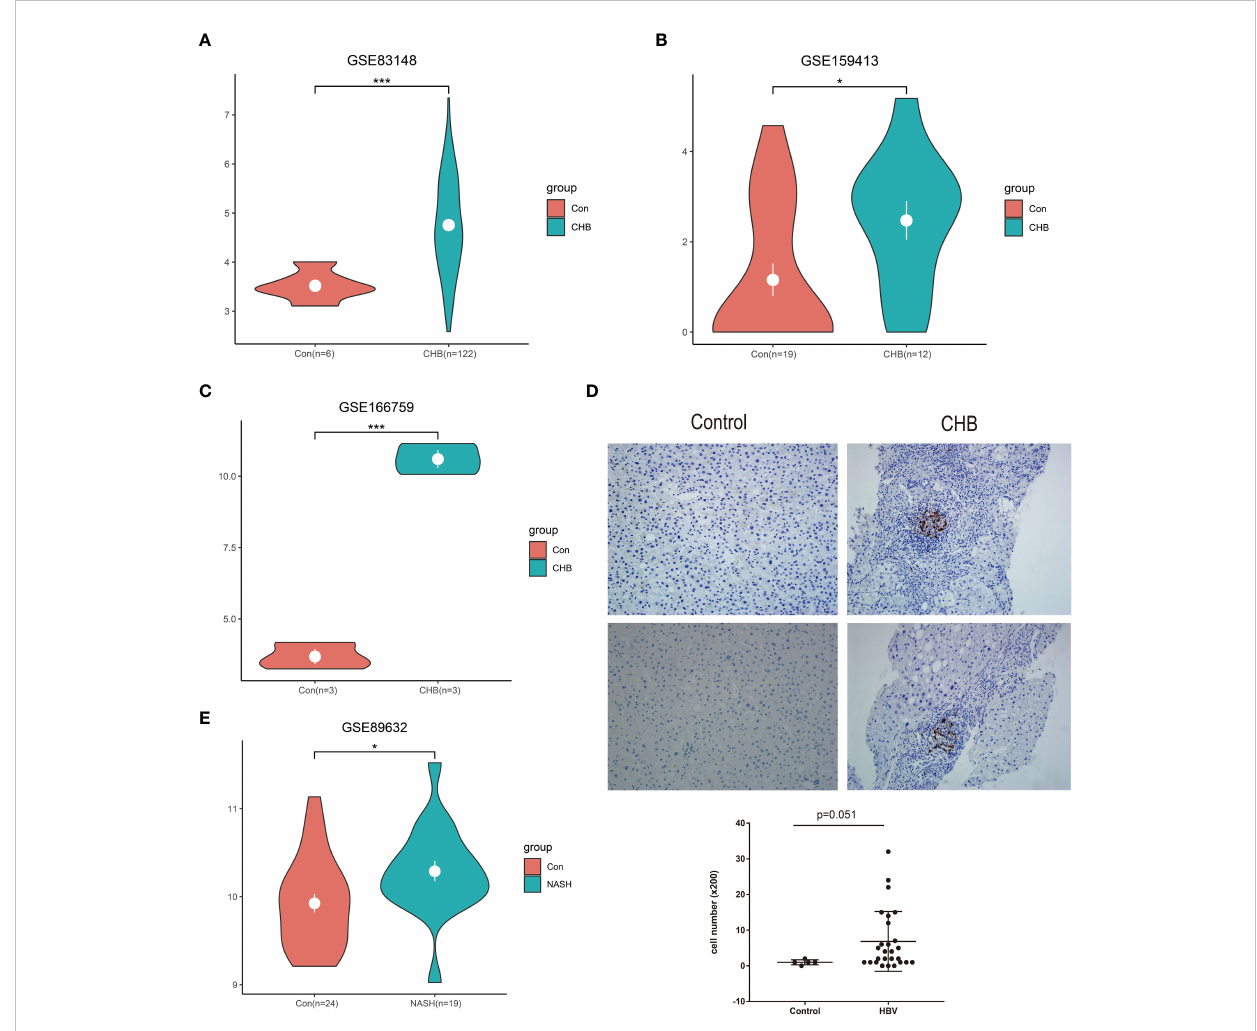
FIGURE 1 Upregulated LAMP3 expression in patients with CHB. (A – C) The comparison of LAMP3 transcriptional levels between patients with CHB and healthy controls in three GEO databases. (D) The expression of LAMP3 in our validation cohort. (E) LAMP3 expressions in patients with NASH and controls. *p <0.05, **p <0.01, ***p <0.001. con, Control; CHB, chronic hepatitis B; GEO, Gene Expression Omnibus; NASH, nonalcoholic steatohepatitis; LAMP3, lysosome-associated membrane glycoprotein